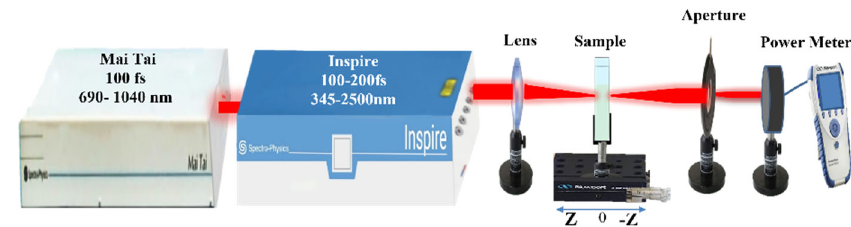
Figure 2. Setup for Z ‐ scan experiment.